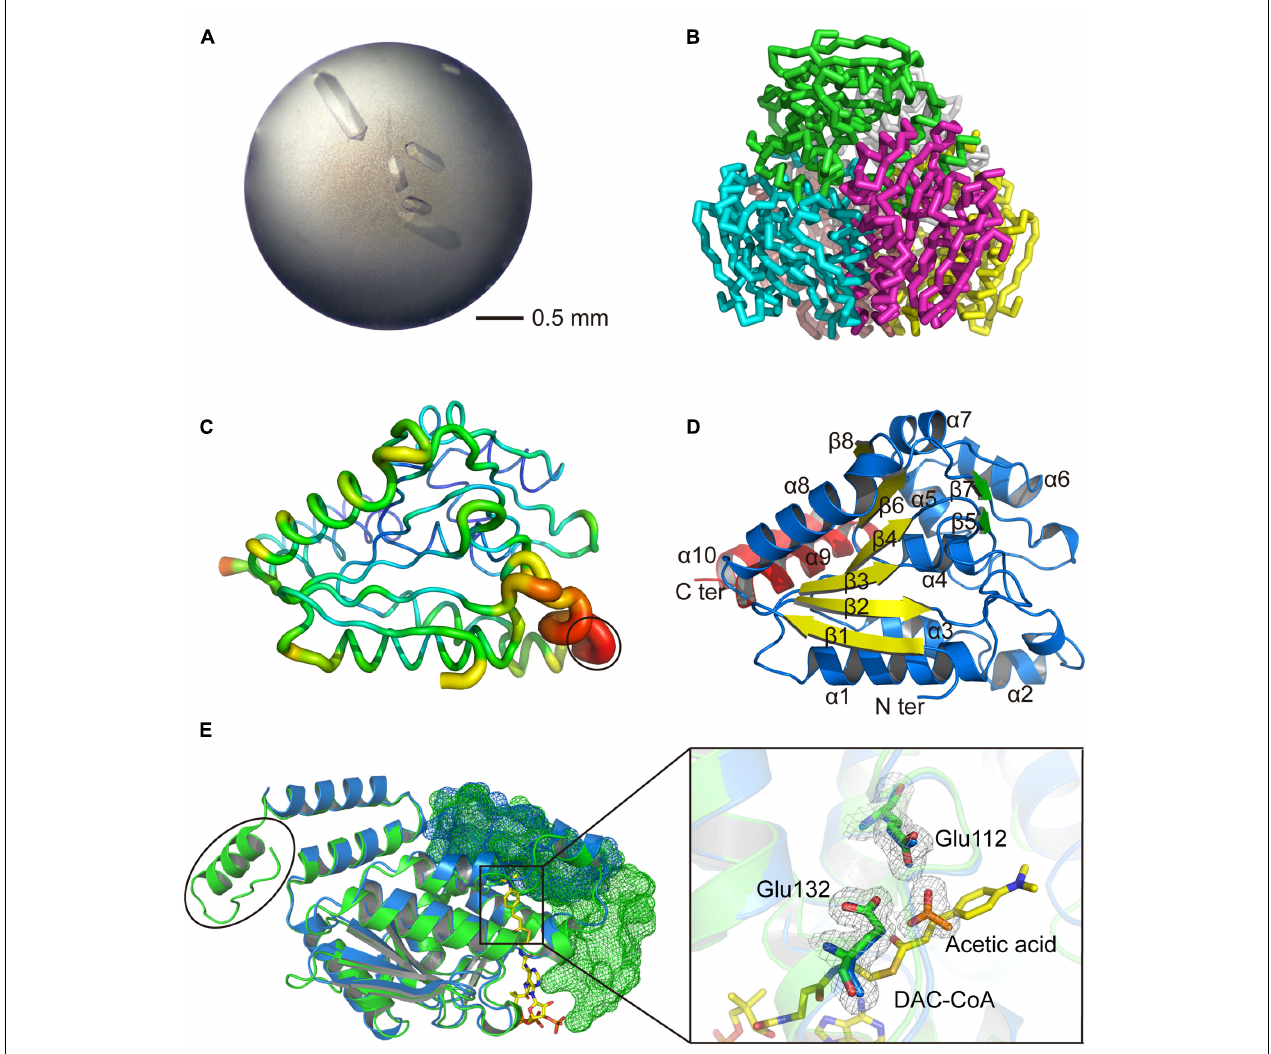
FIGURE 5 | Structural analysis of Rd AcuH. (A) Optimized crystal of Rd AcuH. (B) Overall structure of Rd AcuH. The structure is made up of two stacked trimers. The three subunits in the up trimer are colored in blue, green and magentas, respectively. The other three subunits in the down trimer are colored in pink, gray and yellow, respectively. (C) B-factor view of Rd AcuH monomer (chain A). The B-factor increases from the cool colors to the warm colors and the flexible loop of Rd AcuH is circled out. (D) Cartoon view of Rd AcuH monomer. The two perpendicular β -sheets are colored in yellow and green, respectively, and the CTD is colored in red. (E) Structural alignment of Rd AcuH monomer and the monomer of the enoyl-CoA hydratase from R. norvegicus (PDB code: 1EY3). Rd AcuH is colored in blue and the enoyl-CoA hydratase from R. norvegicus is colored in green. The CTD of the neighboring subunit of the Rd AcuH monomer and the CTD of the neighboring subunit of the monomer of enoyl-CoA hydratase from R. norvegicus are all shown in mesh views. The last 23 residues of the enoyl-CoA hydratase from R. norvegicus are circled out. Glu144 and Glu164 of Rd AcuH are colored in blue and the acetic acid in Rd AcuH is colored in orange. Their 2 Fo - Fc electron density maps are shown at 1.0 σ . In the structure of the enoyl-CoA hydratase from R. norvegicus , Glu144 and Glu164 are colored in green and DAC-CoA is colored in yellow. DAC-CoA represent the possible position of acryloyl-CoA of Rd